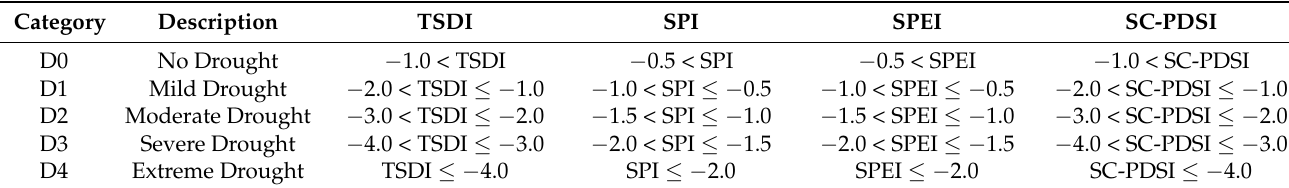
Table 1. Drought severity